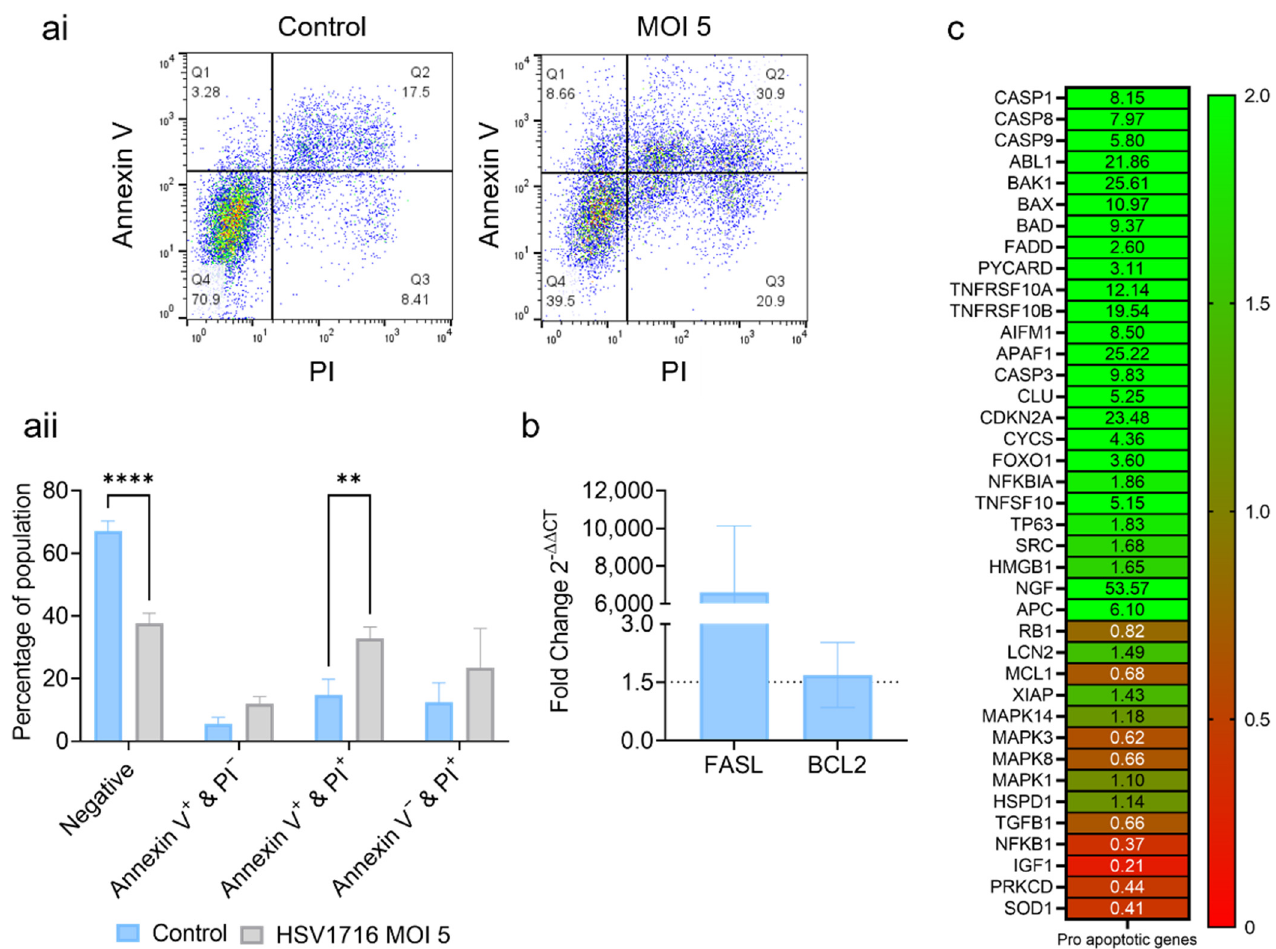
Figure 2. HSV1716 induces tumor apoptosis. JJN-3 cells were infected with HSV1716 at an MOI of 5 for 24 h and a flow cytometry analysis of Annexin-V and PI staining was carried out to assess apoptosis. ( ai ) Flow cytometry scatter plots showing Annexin-V vs. PI staining in control or HSV1716-treated cells. ( aii ) Percentages of cells in each population after Annexin-V and PI staining. Data are means ± SEMs, n = 3, ** = p < 0.01, **** = p < 0.0001 with respect to the relevant control, analyzed using a T-test. ( b ) The qPCR analysis of JJN-3 cells 24 h post-infection as fold changes over untreated controls. The analysis for the pro-apoptotic gene FASL and anti-apoptotic gene BCL2 following HSV1716 (MOI 5) treatment. The dotted line indicates the point at which significant upregulation can be seen (1.5-fold increase in expression) Data are means +SEMs, n = 3. ( c ) JJN-3 cells were infected with control or HSV1716 MOI 5. After 24 h, the total RNA was extracted and cDNA was synthesized. A PrimePCR TM SYBR ® Green-based apoptotic microarray (BIO-RAD) was performed to detect apoptotic gene expression via RT-qPCR.